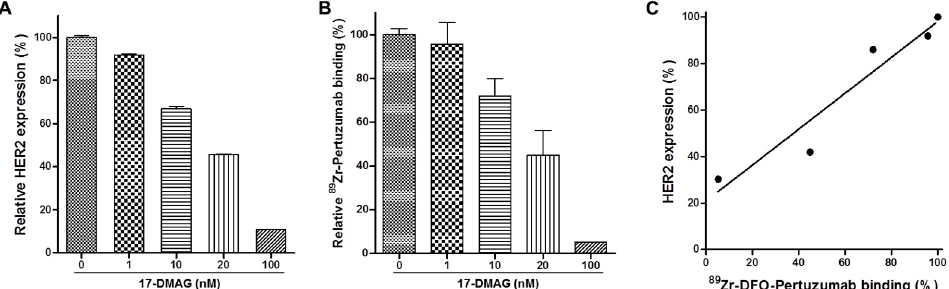
Figure 2. Pharmacodynamic change of HER expression level by treatment of heat shock protein 90 inhibitor in JIMT-1 breast cancer cells. ( A ) Flow cytometric analysis of HER2 expression of JIMT-1. Pertuzumab used as the primary antibody and monoclonal anti-human FITC-conjugated IgG antibody as the secondary antibody. ( B ) In vitro cell binding assay of 89 Zr-DFO-pertuzumab. JIMT-1 cells were treated with various concentrations of heat shock protein 90 inhibitor (17-DMAG) for 24 h. ( C ) Correlation between flow cytometry analysis and cell binding assay. Correlation (r) = 0.9596.